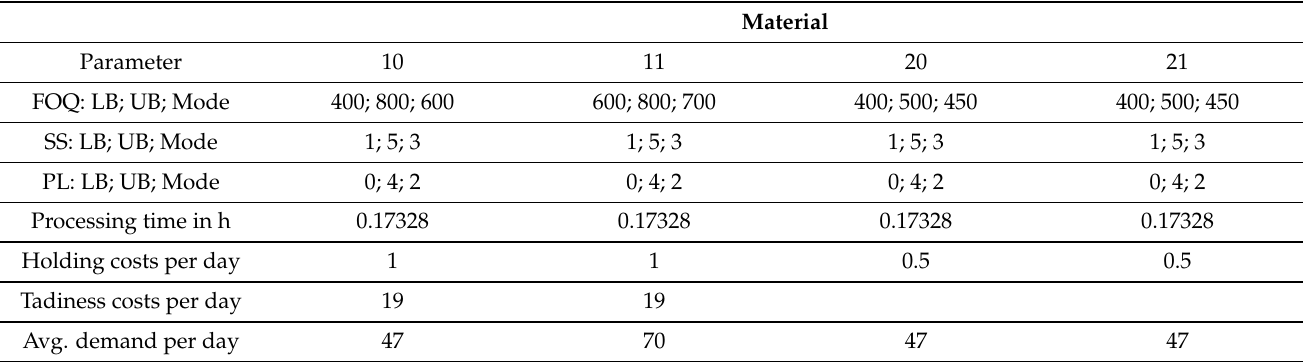
Table 3. Values of the simulation parameters employed.